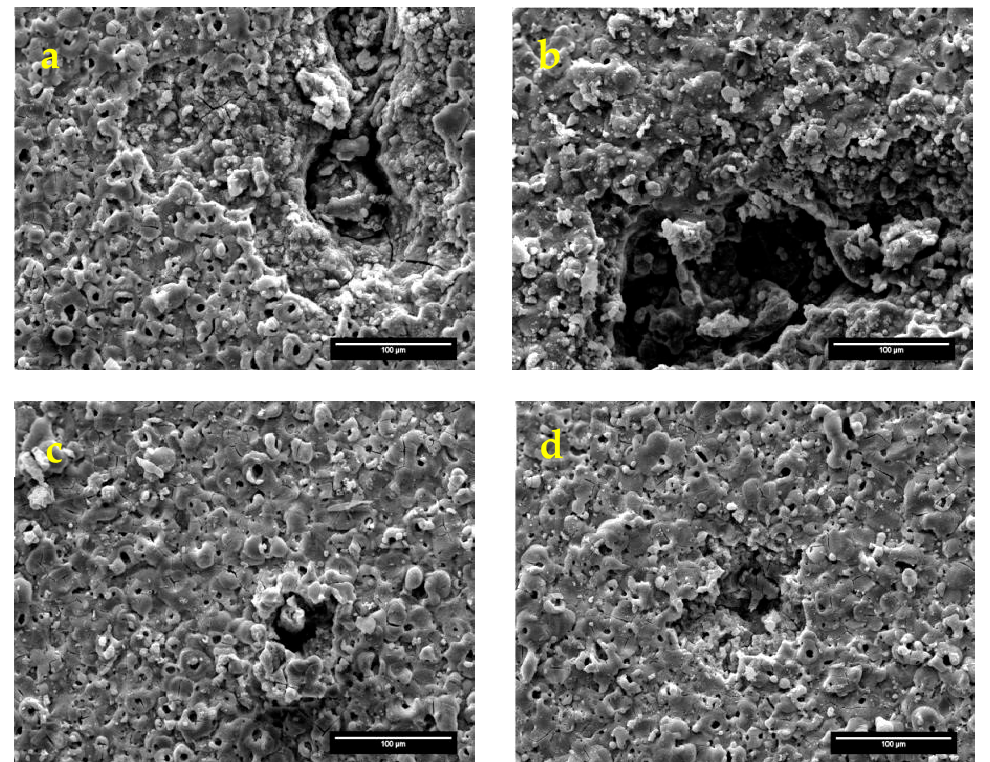
Figure 13. Surface morphology of plasma electrolytic oxidation (PEO) coating after 3 weeks of immersion in 3.5 wt. % NaCl solution for: ( a ) U, ( b ) B1, ( c ) B2 and ( d ) B3 waveforms.